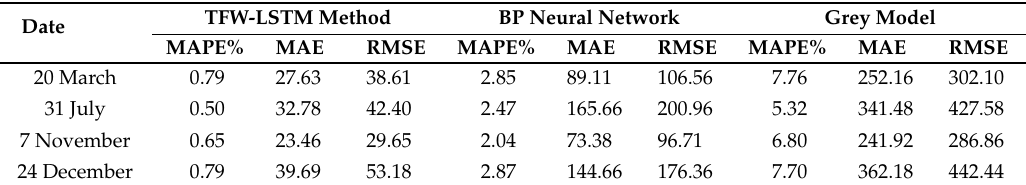
Table 4. The comparison result table of proposed method and traditional method.